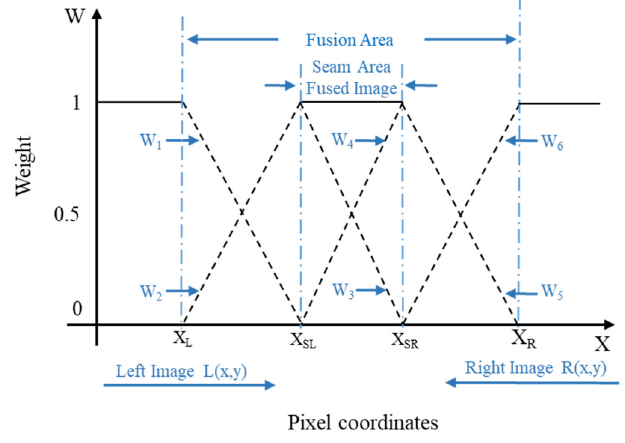
Figure 5. Diagram of the improved fade-in and fade-out weighted image fusion algorithm.